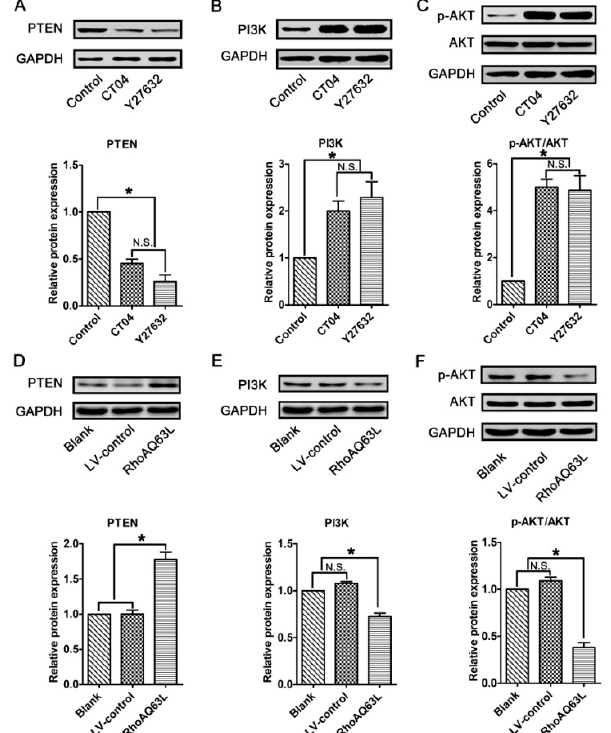
Figure 8. The RhoA signaling pathway negatively regulates the AKT signaling pathway in neuronally differentiated PC12 cells. ( A – C ) Western blots showed that the level of PTEN was remarkably downregulated, while PI3K and p-AKT were dramatically upregulated in CT04- or Y27632-treated cells. ( D – F ) Conversely, the overexpression of constitutively activated RhoA resulted in the upregulation of PTEN and the downregulation of PI3K and p-AKT. The protein level in the control group was normalized to 1. The data are shown as the mean ± SEM values (*indicates p < 0.05, meaning a statistically significant difference, while N.S. indicates non-significance).